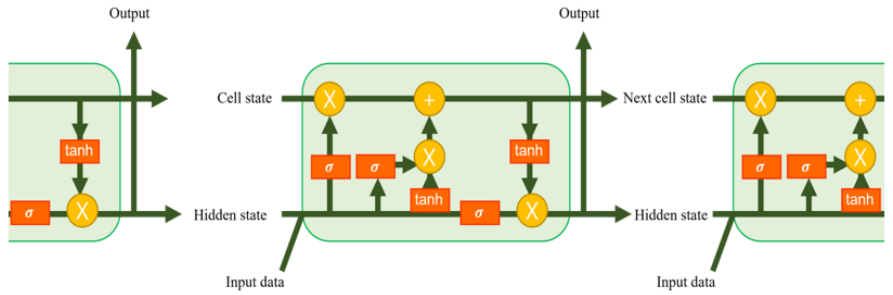
Figure 2. Architecture of LSTM.